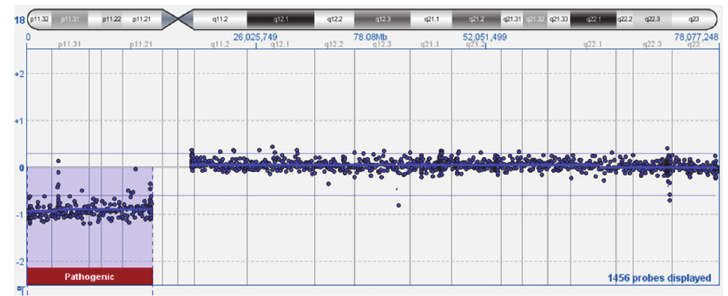
Figure 3: SNP based chromosome microarray confirmed a copy loss of ∼ 13.93 Mb of 18p11.21p11.32, the entire short (p) arm of chromosome